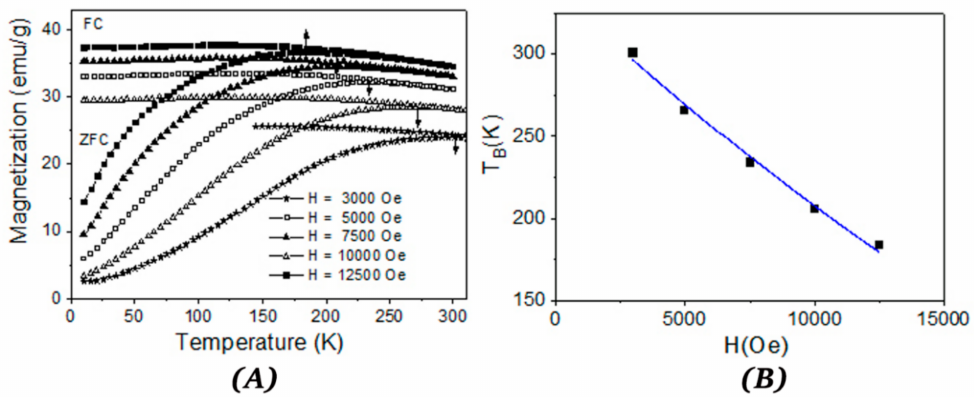
Figure 6. Zero field cooled / field cooled (ZFC-FC) curves at various fields ( A ) and blocking temperature (TB) dependence on applied magnetic field ( B ) for sample CFO73.